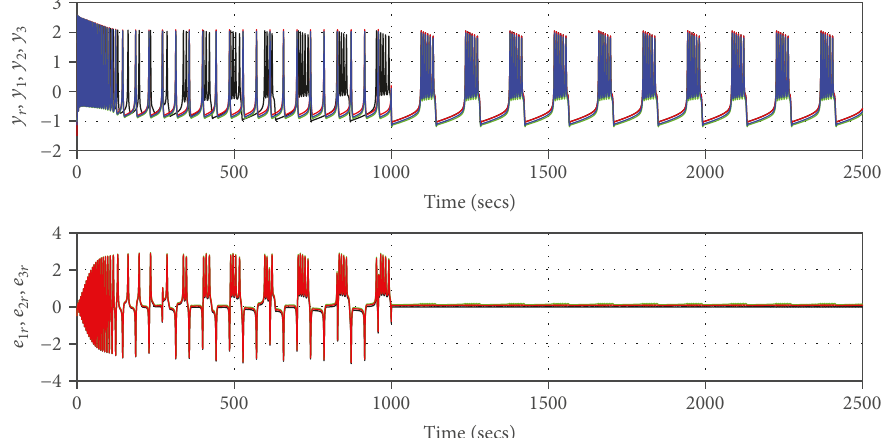
Figure 6: Outputs y